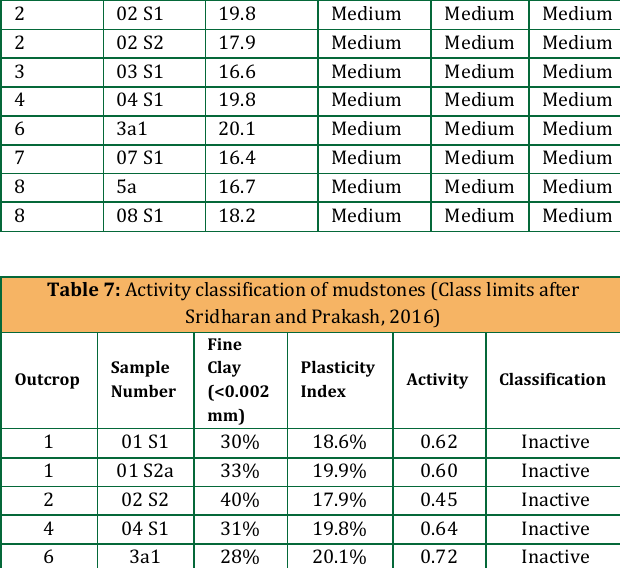
Table 4: Consistency limits of mudstones from different slope cuts along Jalan Sungai Hitam, Libaran, Sandakan Outcrop